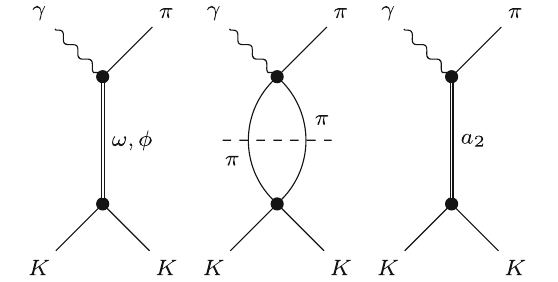
Fig. 1 t -channel contributions to γ K → K π ; see main text for the individual terms 3 Singularities in the t